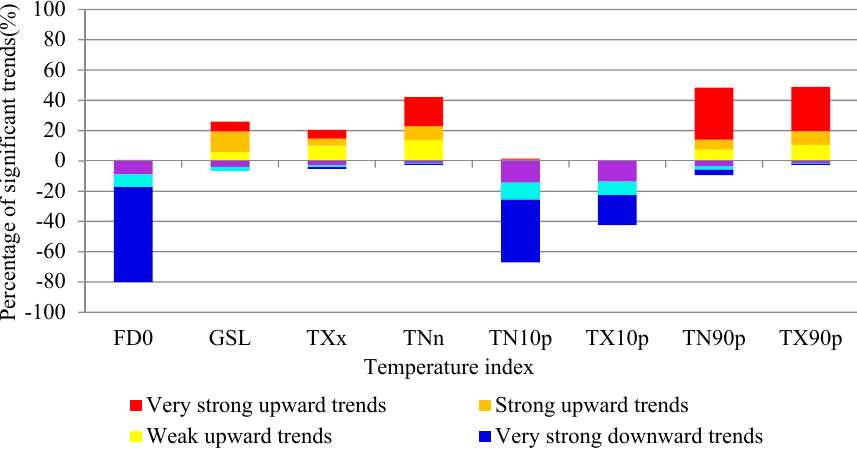
Figure 2. Percentages of trend (PCT) with different significant levels for each extreme temperature index in the study area during the growth period of October 1961 to May 2016.